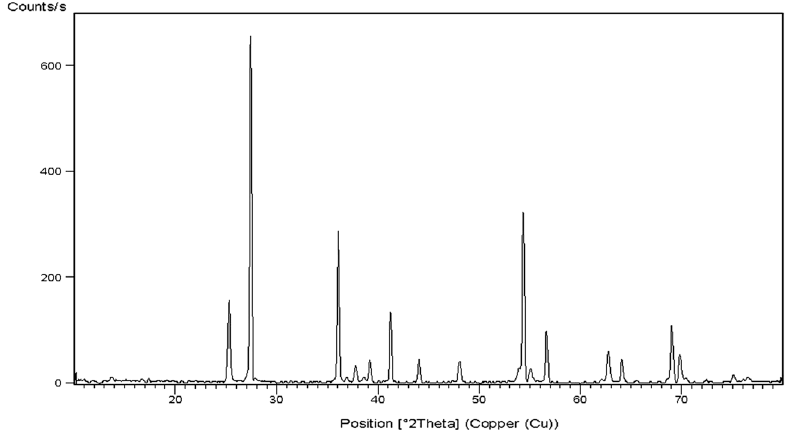
Figure 1. X-Ray Diffraction pattern (XRD) of TiO 2 NPs.